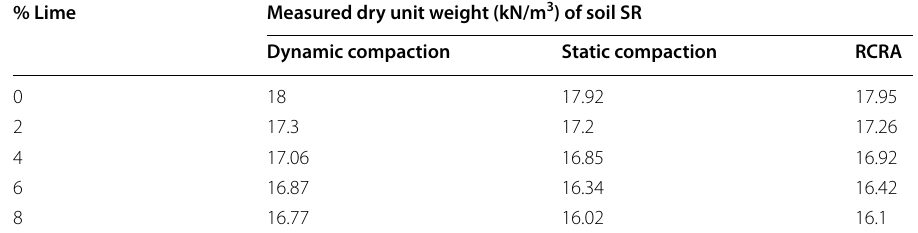
Table 9 Measured dry unit weight of soil SR treated by lime % Lime